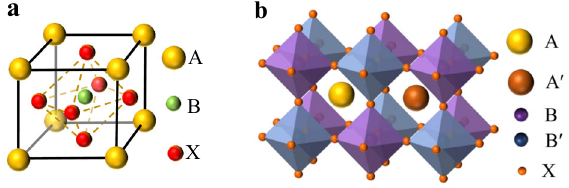
Fig. 3 Structures of different perovskites. a Simple perovskite cubic crystal structure and b Double perovskite crystal